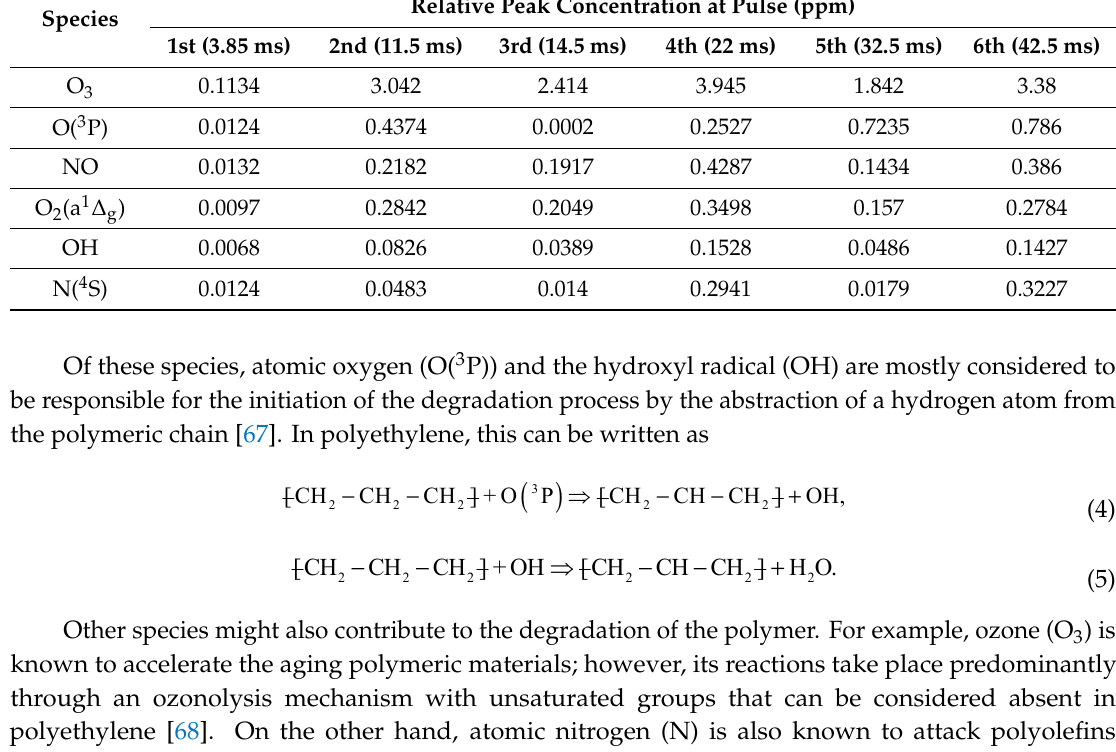
Table 2. Relative peak concentration of the most abundant species.